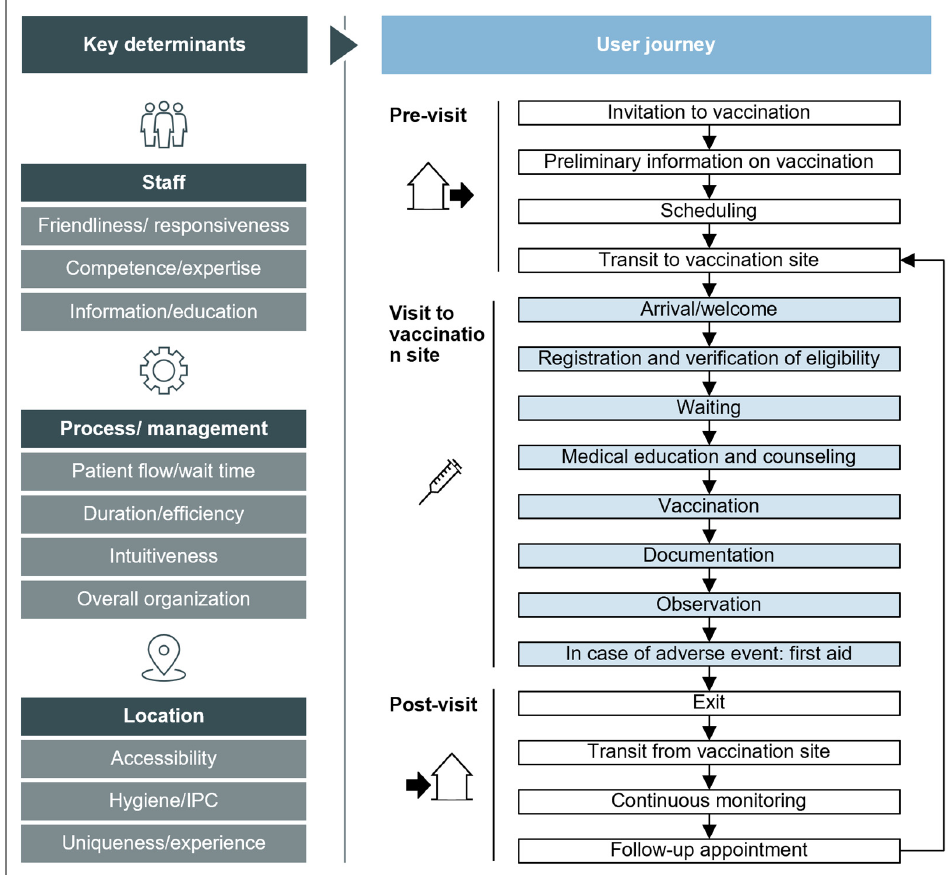
Figure A2. Framework for vaccination center user experience combining key determinants of user experience and the vaccination center user journey.